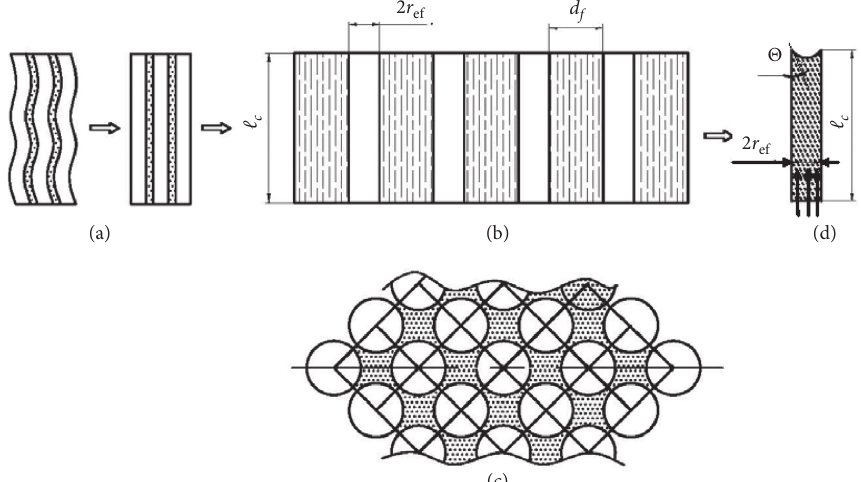
Figure 12: An illustration of the implementation of the methodology for constructing (a)–(d) an adequate geometric model of the microstructure of OFF in the technology of their “free” impregnation with a liquid epoxy binder: r ef is the effective capillary radius; d f is the average fiber diameter; ℓ c is capillary length; θ is the wetting contact